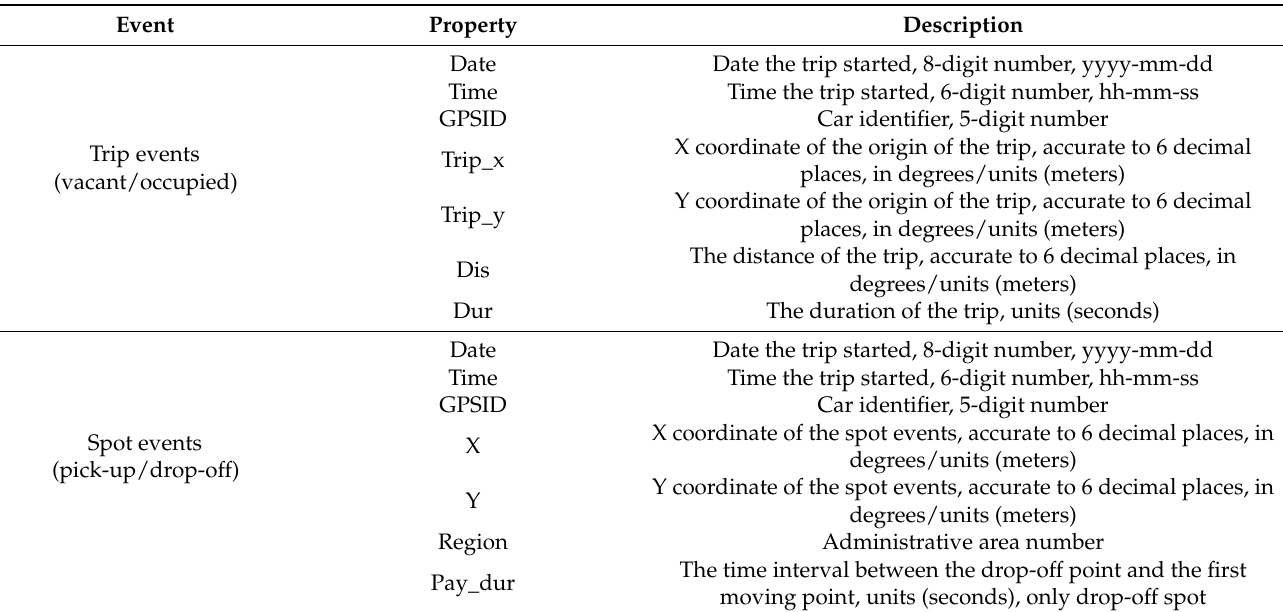
Table 1. Description of driving behavior